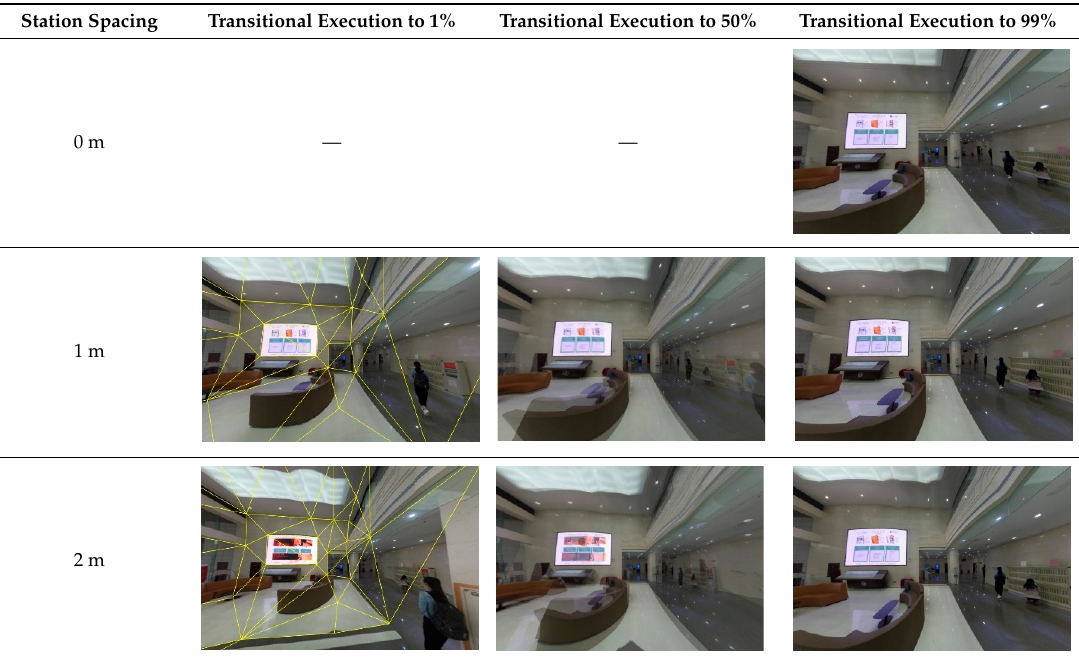
Table 3. Robustness performance of the proposed method with six tests.